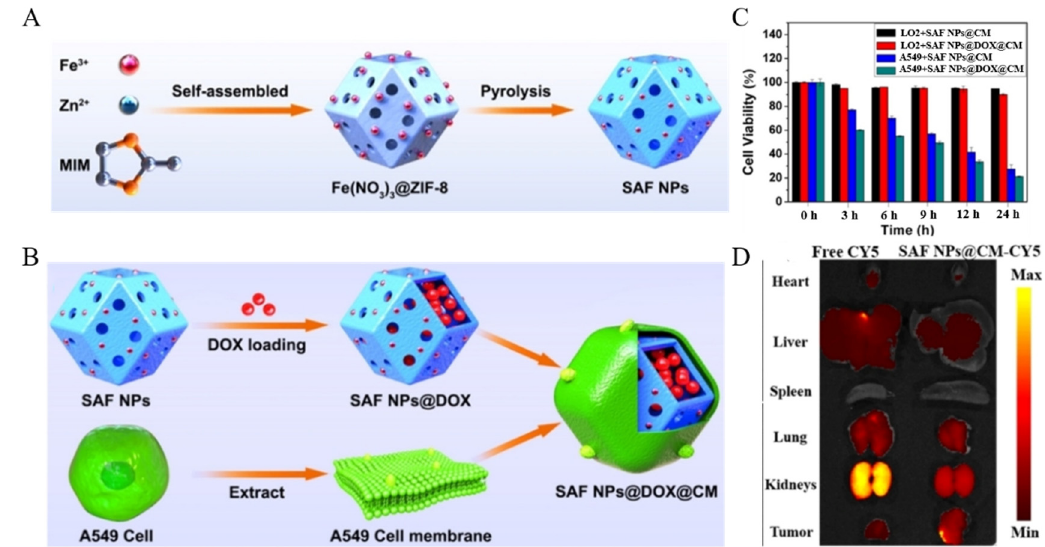
Figure 6. Preparation of SAF NPs ( A ) and SAF NPs@DOX@CM ( B ). ( C ) Viability of cells treated with SAF NPs@CM and SAF NPs@DOX@CM. ( D ) Fluorescence intensities of major organs and tumors after 24 h intravenous injection of free CY5 and SAF NPs@CM-CY5 [89]. Copyright 2021, Wiley-VCH.